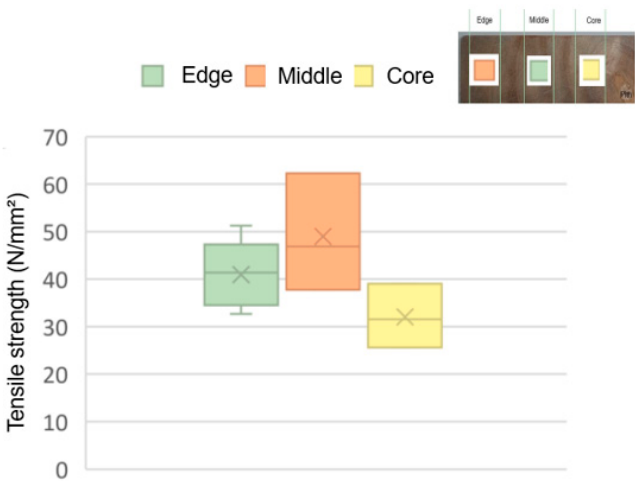
Figure 19. Tensile strength of Paulownia samples extracted from the